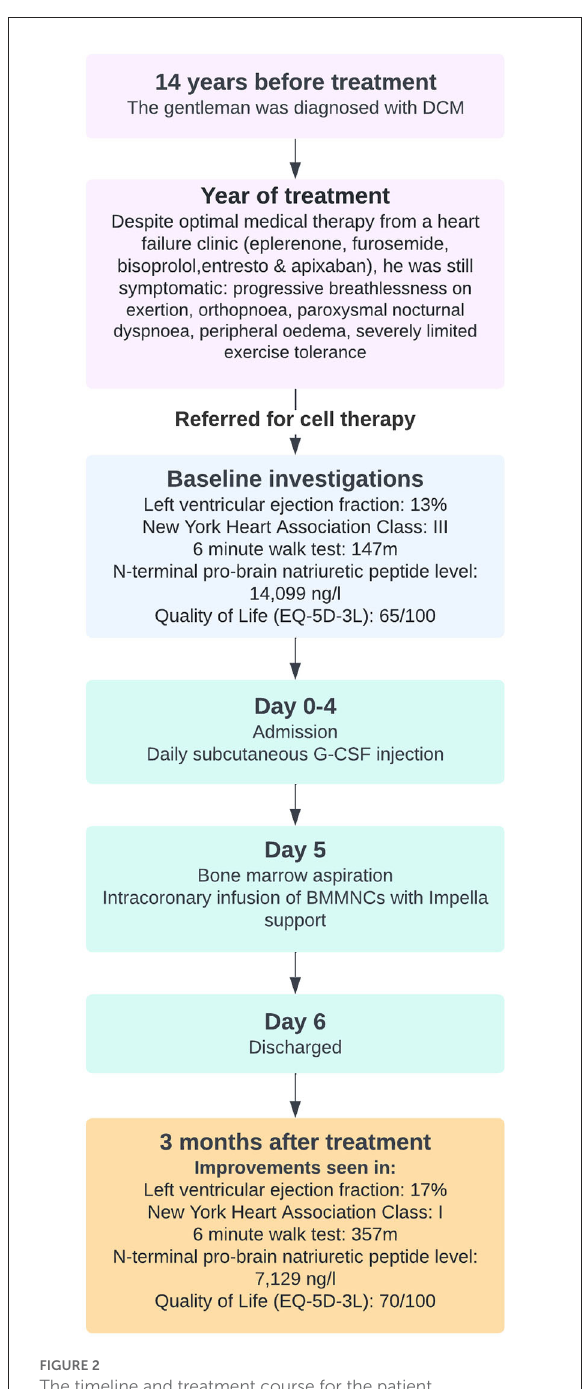
FIGURE2 The timeline and treatment course for the patient.